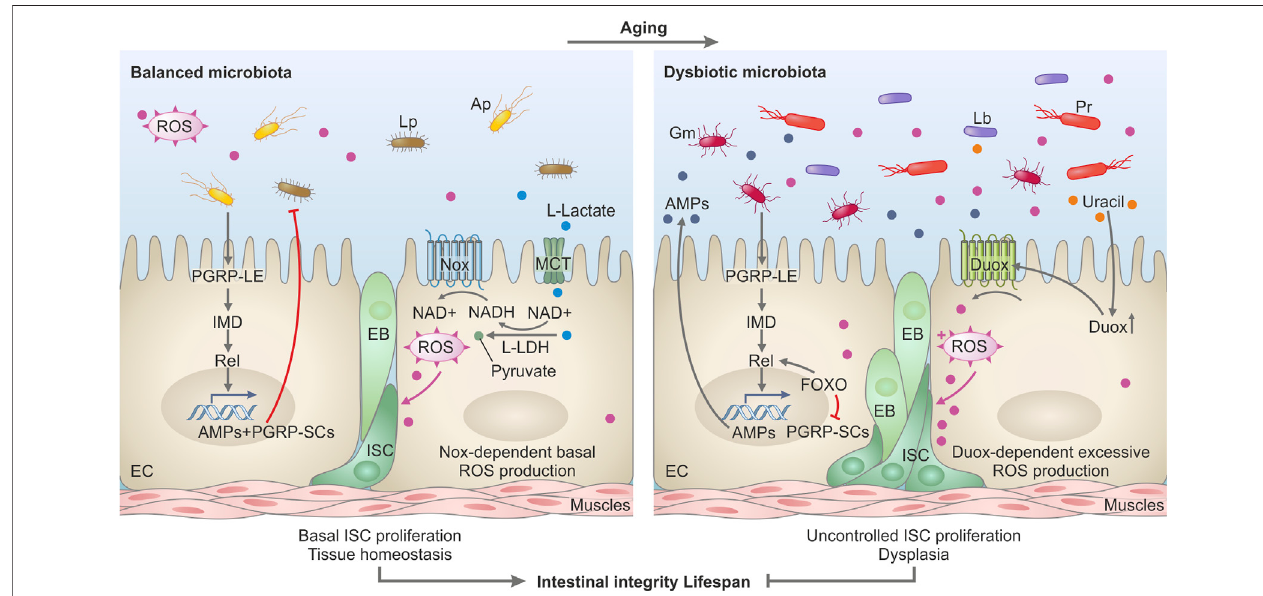
FIGURE1| Model depicting theimpact ofmicrobiota on intestinal homeostasisduringagingin Drosophila . Inahealthy, younggut (left panel),themicrobiotahelps to sustain intestinal homeostasis, intestinal integrity, and optimal lifespan. Commensal bacteria like L. plantarum release L-lactate in the intestine. L-lactate enters the intestinal cells via monocarboxylate transporters (MCT) and is oxidized by the host lactate dehydrogenase (LDH), thus generating NADH. NADH is used by the NADPH- oxidase Nox to generate Reactive Oxygen Species (ROS) which stimulate basal intestinal stem cell (ISC) proliferation and differentiation in EnteroBlasts (EB) and Enterocytes(EC)toensuretissuehomeostasis. L.plantarum (Lp)andothercommensalssuchas A.pomorum (Ap)stimulatebasalIMDpathwayactivitybytriggeringthe receptorPGRP-LEandtheRelishtranscriptionfactorwhichconsequentlyinducesexpression ofPGRP-SCsandantimicrobialpeptides(AMPs) — moleculesthatcontrol the proliferation of the commensal bacteria. In the aging gut (right panel), the activated FOXO transcription factor boosts Relish activity and AMPs genes expression but suppresses PGRP-SCs expression. Such an environment with an excessive amount of AMPs and reduced production of PGRP-SCs favors the emergence and selection of pathobionts in the commensal community. Such pathobionts like G. morbifer (Gm), L. brevis (Lb), or P. rettgeri (Pr) are resistant to AMPs and release uracil which promotes excessive ROS production via activation of DUOX. DUOX-dependent ROS in turn stimulates uncontrolled ISC proliferation and defective differentiation resulting in gut dysplasia, loss of tissue integrity, and reduced